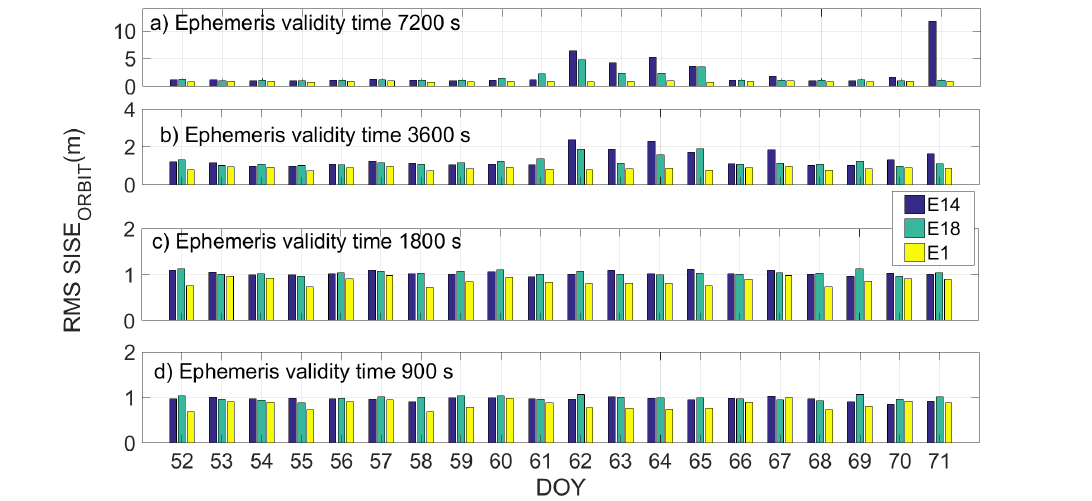
Figure 10. Daily RMS SISE orbit for satellite Milena (E14) and Doresa (E18) and satellite 1 (E1) represented by blue, green and yellow bars, respectively. SISE orbit was calculated using a validity time of 7200 s, 3600 s, 1800 s and 900 s in ( a – d ), respectively.